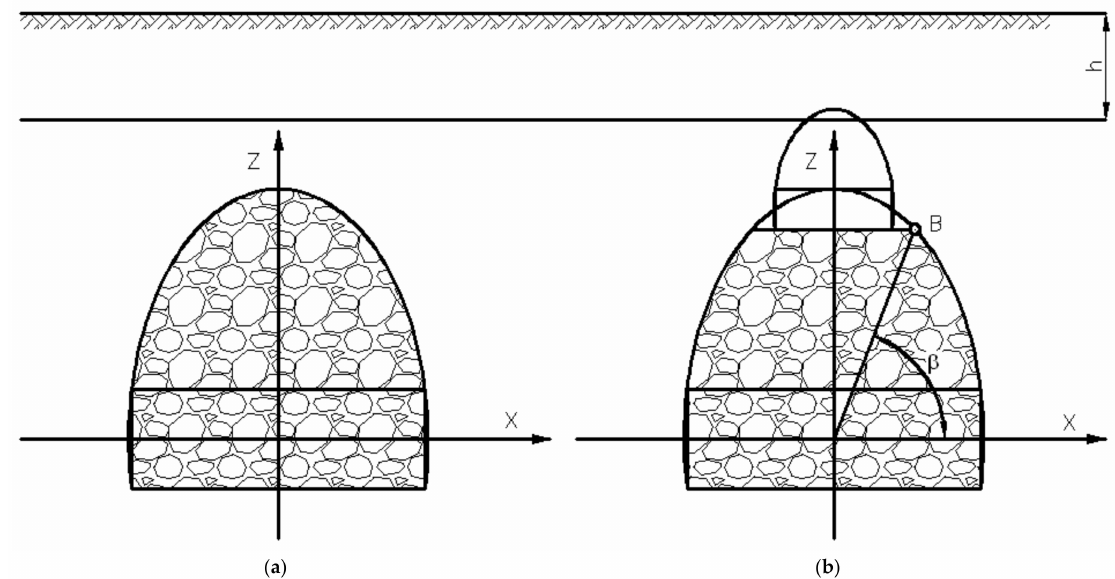
Figure 3. Possibilities of caved zone occurrence in the vicinity of a void [12,13]: ( a ) rocks originally contained in the relaxed zone, after crushing, tightly fill the excavation (void) and the relaxed zone; ( b ) when void is filled with crushed rocks from the relaxed zone, a secondary void is created at the upper point of the ellipse.